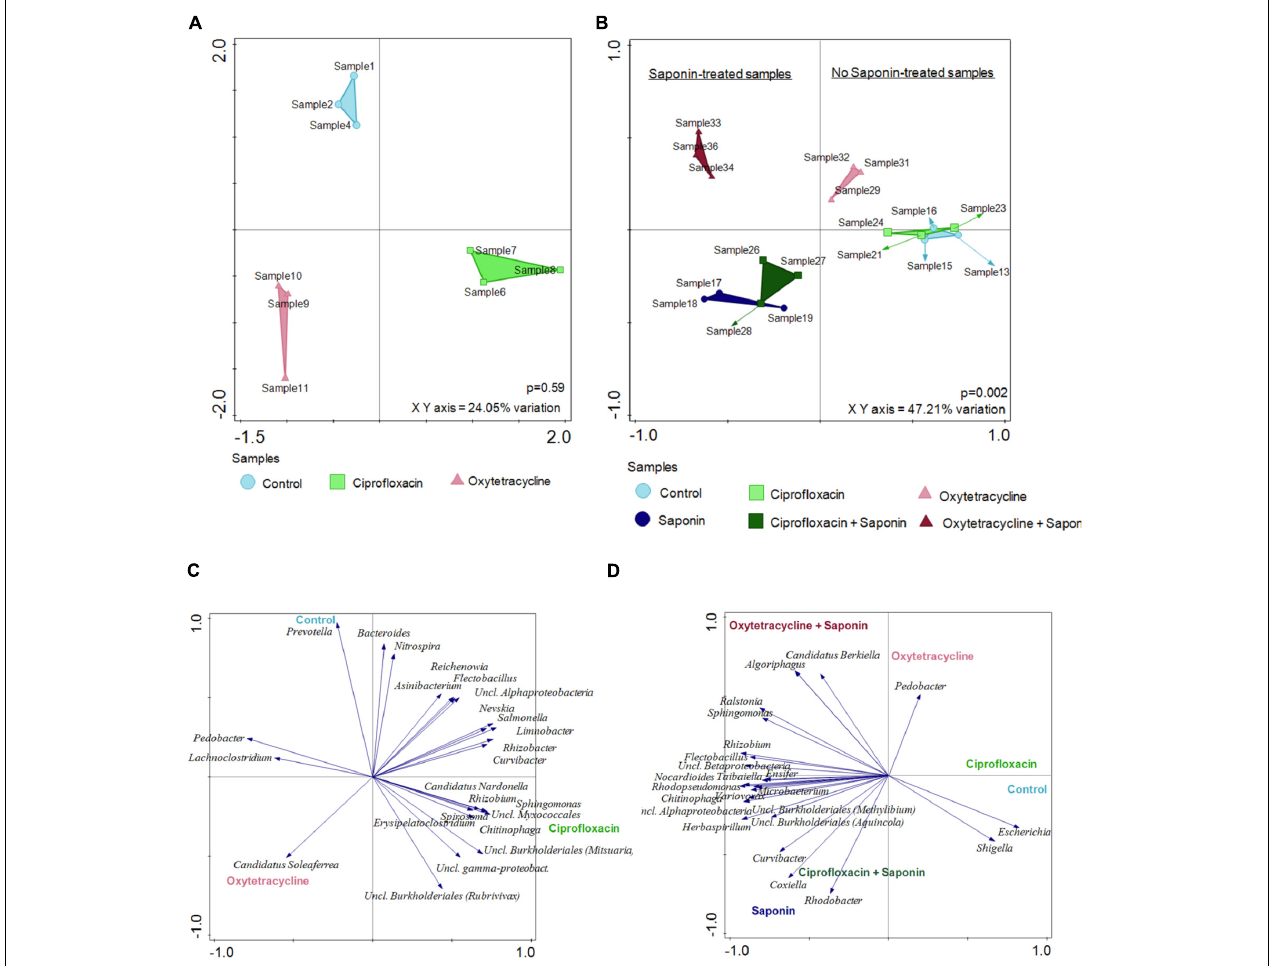
FIGURE 7 | Saponin promoted a microbiome shift which was further enhanced by oxytetracycline in zebrafish larvae. Redundancy Analysis (RDA) was performed at 6dpf (A) and at 9 dpf (B) ( n = 3 pools of 5 larvae/treatment). The distances among the samples approximates the average dissimilarity of the genera composition between the two samples being compared as measured by Euclidean distances. The top 25 most discriminating (not per se most abundant) OTUs are displayed at (C) 6 dpf and (D) 9 dpf for all the